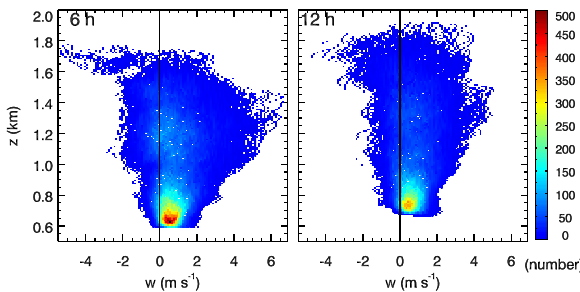
Fig. 7. Distribution of vertical velocity in cloudy grids. The bin width is 0.1ms − 1 . The black lines indicate the zero vertical ve- locity. Downdrafts occur in clouds, but are much weaker and less frequent than